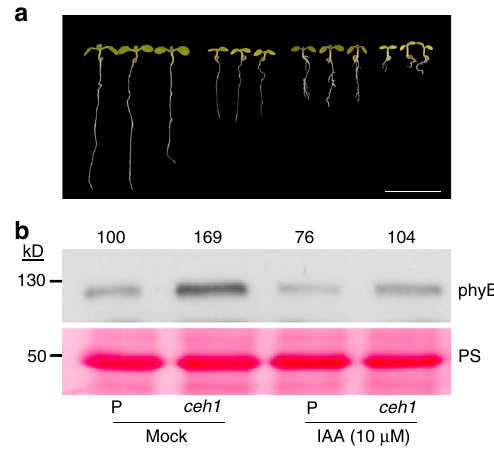
Fig. 5 Auxin treatment reduces phyB protein in ceh1 . a Representative images of 7-day-old LD (16 h light/8 h dark) grown P and ceh1 seedlings in the absence (mock, 0.01% ethanol) and the presence of IAA. Scale bar: 1 cm. b Abundance of phyB protein in total protein extracts of P and ceh1 seedlings grown in the absence (mock) and presence of IAA. Numbers above the immunoblot image represent normalized phyB abundance in mock and IAA treated seedlings relative to P plants. Ponceau S (PS) staining was used as the loading control